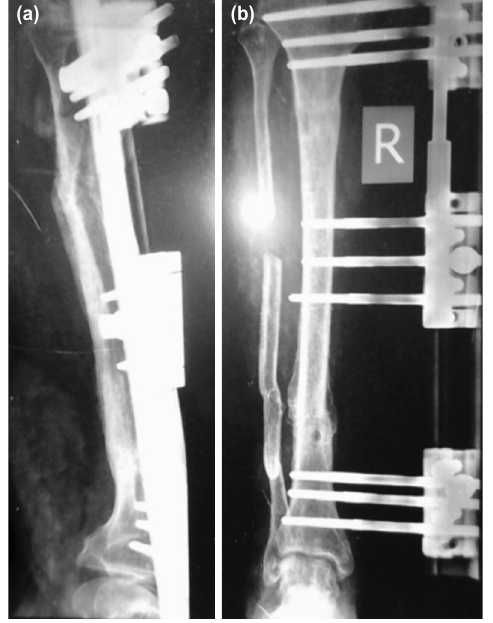
(a) Anterior posterior and (b) lateral plain radiograph Fig. 3: showing tibia fracture treated with Debridement, acute docking, primary bone graft and proximal corticotomy.